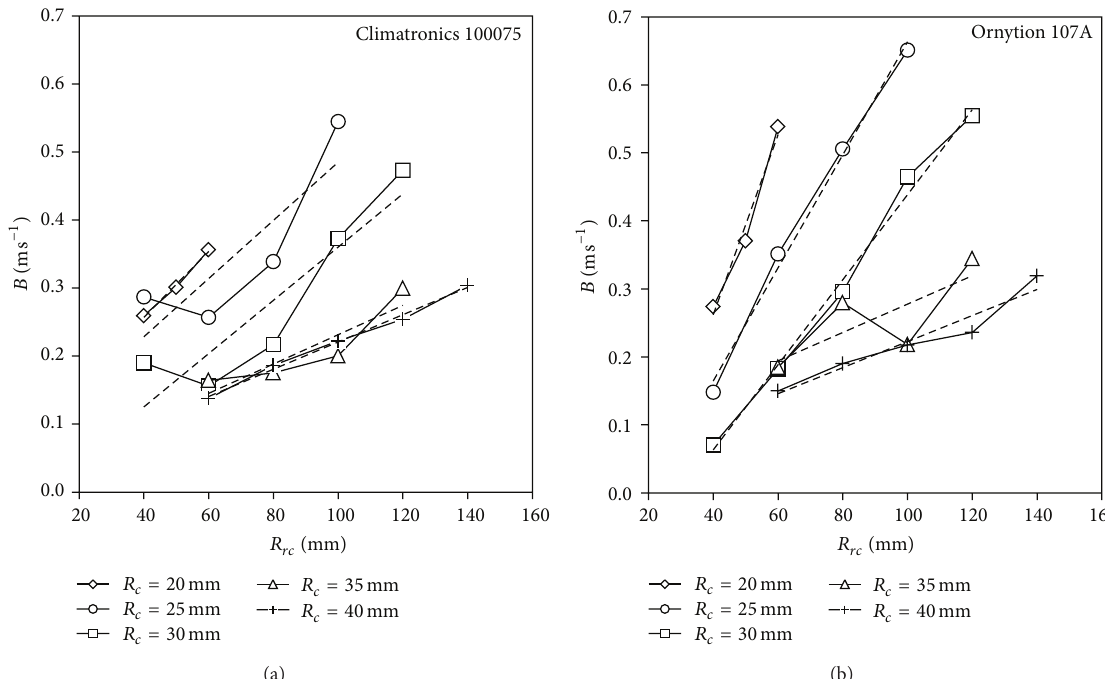
Figure 9: Coefficient 𝐵 for the calibrations performed (see Table 2) on the Climatronics 100075 and the Ornytion 107A anemometers, shown as a function of the cup center rotation radius, 𝑅 𝑟𝑐 , for each cup radius, 𝑅 𝑐 . Linear fittings to the data are also shown in the graphs (the coefficients of these fittings, d 𝐵/ d 𝑅 𝑟𝑐 and 𝐵 0 , are included in Table 2).